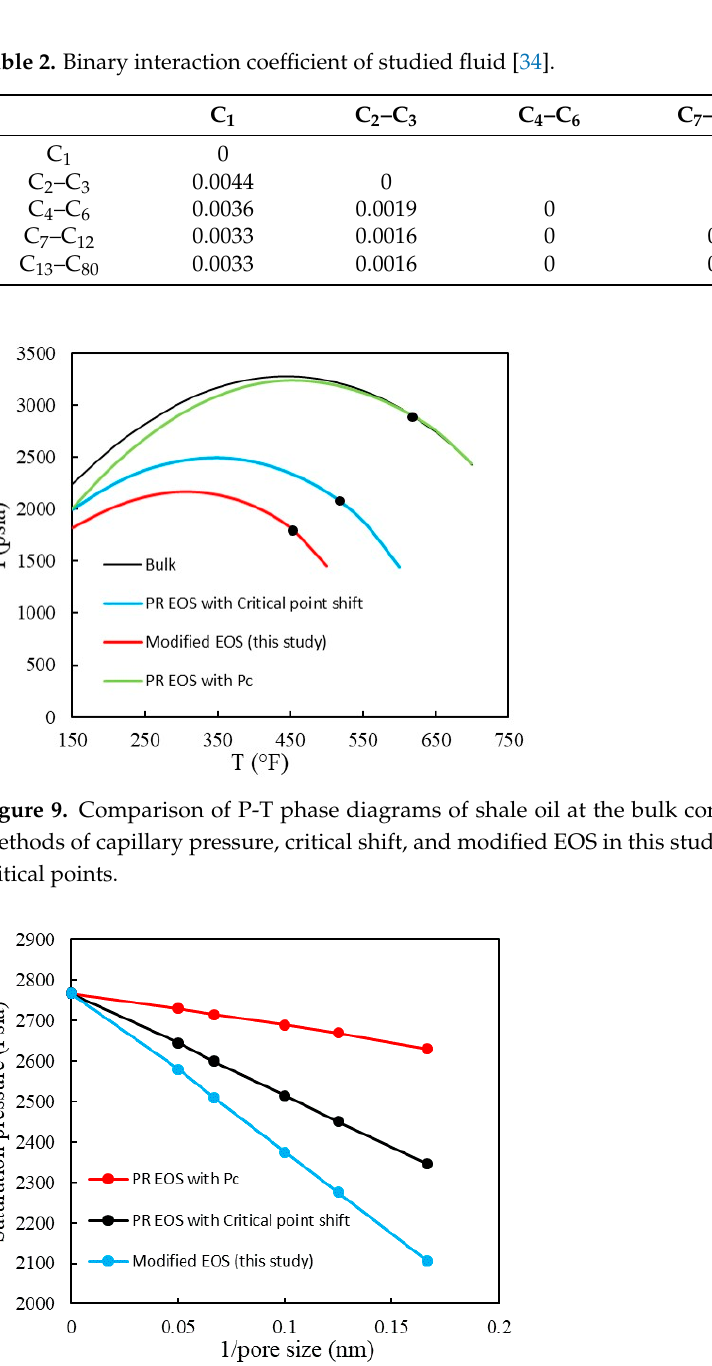
Figure 10. Calculated saturation pressures in different size of nanopores when using methods of capillary pressure, critical shift, and modified EOS at T = 240 °F.